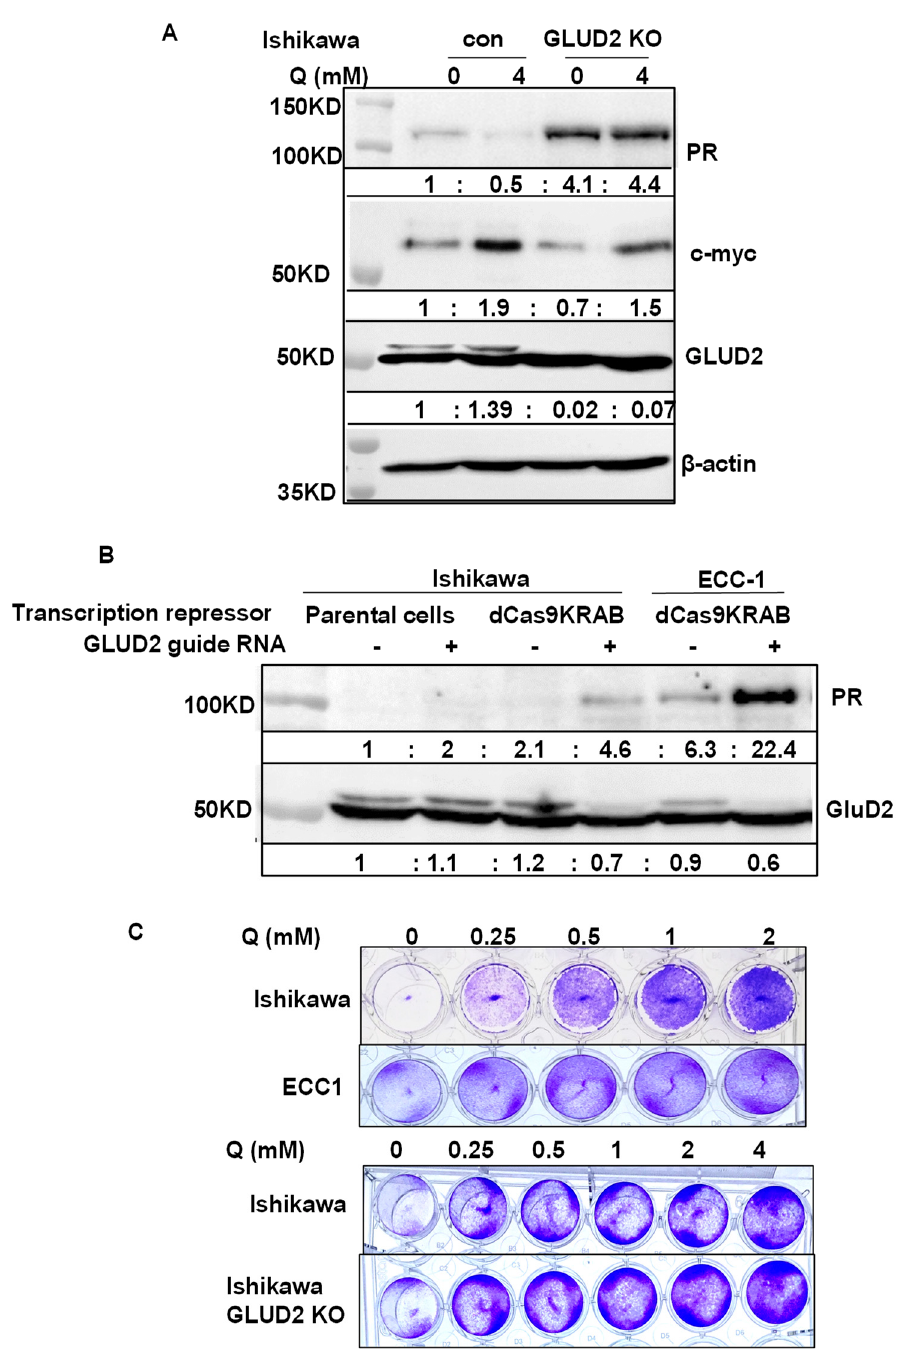
Figure 5. Validation PR expression regulated by GLUD2 identified from GeCKO library and GLUD2 involved glutamine. ( A ) Increased PR expression was detected in GLUD2 knockout Ishikawa cells compared to empty lentiCRISPR v2 vector infected cells. Increased PR expression was also detected in Ishikawa cells infected with empty lentiCRISPR v2 vector after 3 days’ glutamine starvation, compared to cells cultured with 4 mM glutamine. ( B ) Increased PR expression was detected in GLUD2 promoter repressed Ishikawa and ECC1 cells mediated by dCas9KRAB and GLUD2 promoter targeting giRNA. ( C ) Growth addiction to glutamine of Ishikawa, ECC1, and Ishikawa with GLUD2 knockout cells was detected by growing at the indicated concentration of Glutamine for one week.